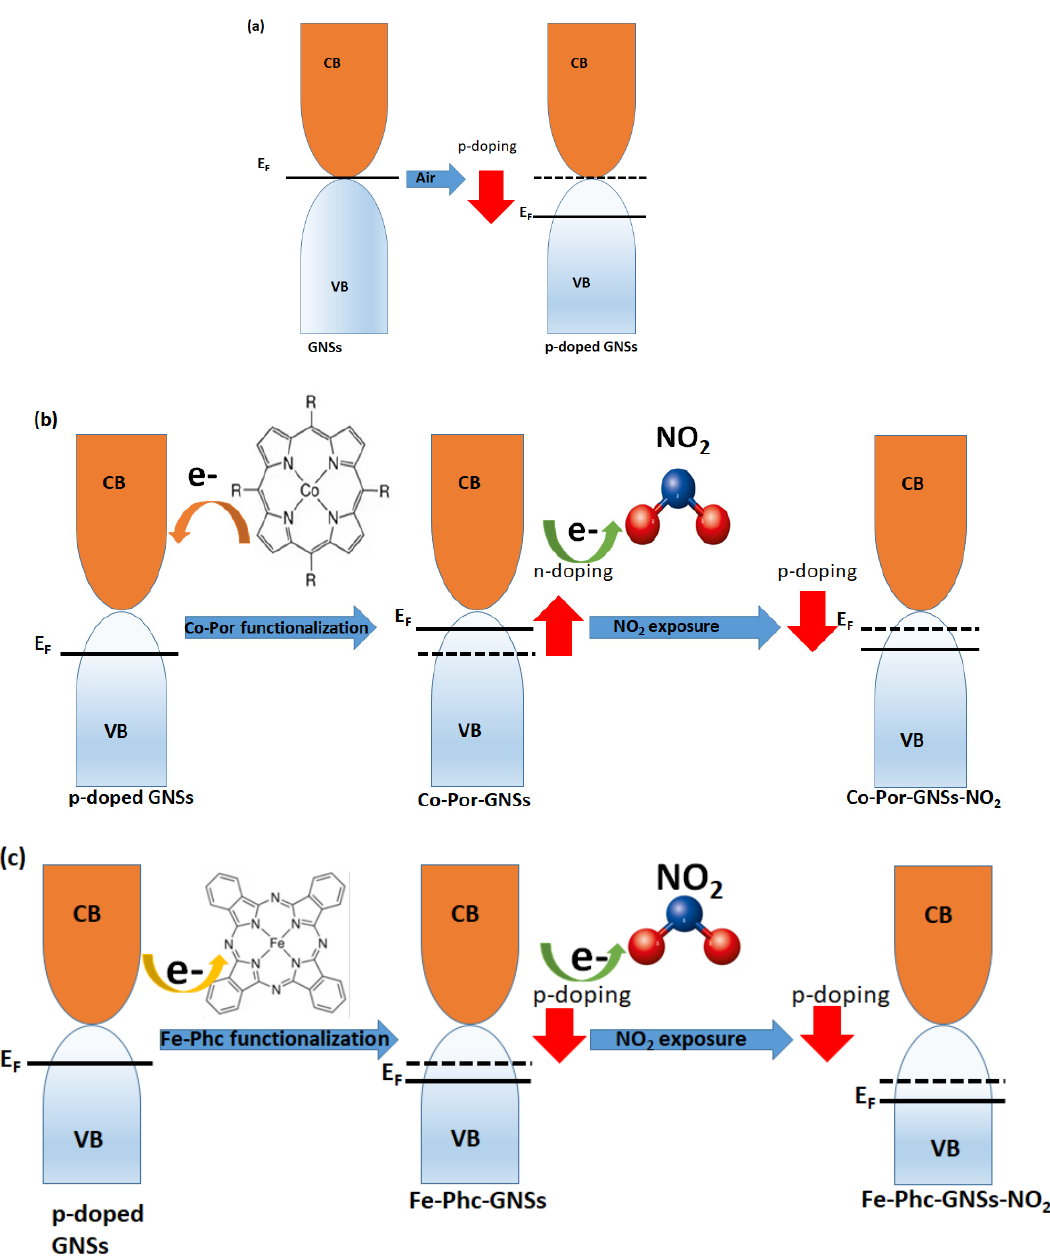
Figure 11. Schematic band diagram of the GNSs and functionalized GNSs before and after exposure to NO 2 .